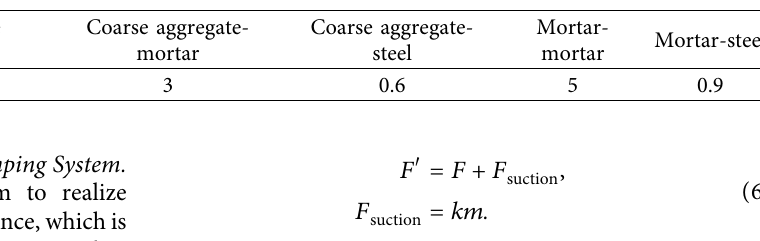
Table 2: The surface energy of the final DEM model of fresh